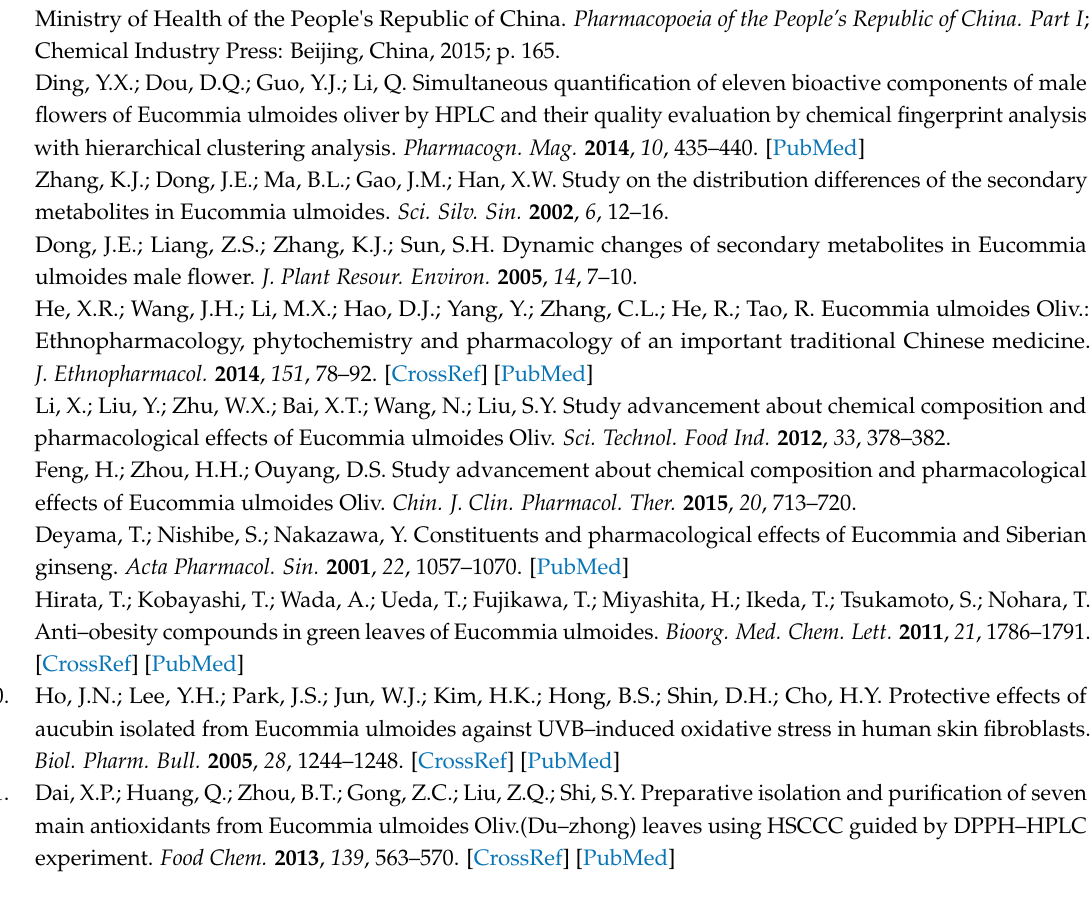
Supplementary Materials: The following are available online. Figure S1: Chemical structures of 21 reference substances, Table S1: The data matrix applying PCA, Table S2: The p1 and p2 values of the points in PCA loading